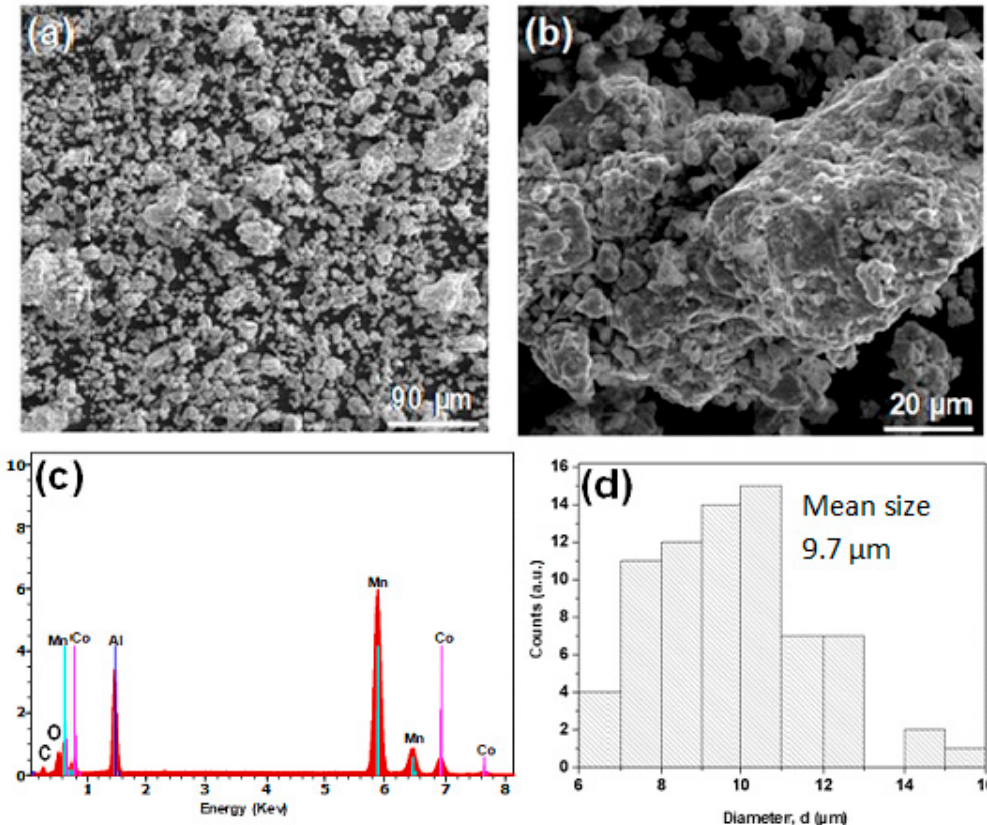
Figure 2. ( a , b ) Particle morphologies of the MA Mn-Al-Co powder. ( c ) EDS microanalysis and ( d ) distribution of particle sizes of the ball milled powder.